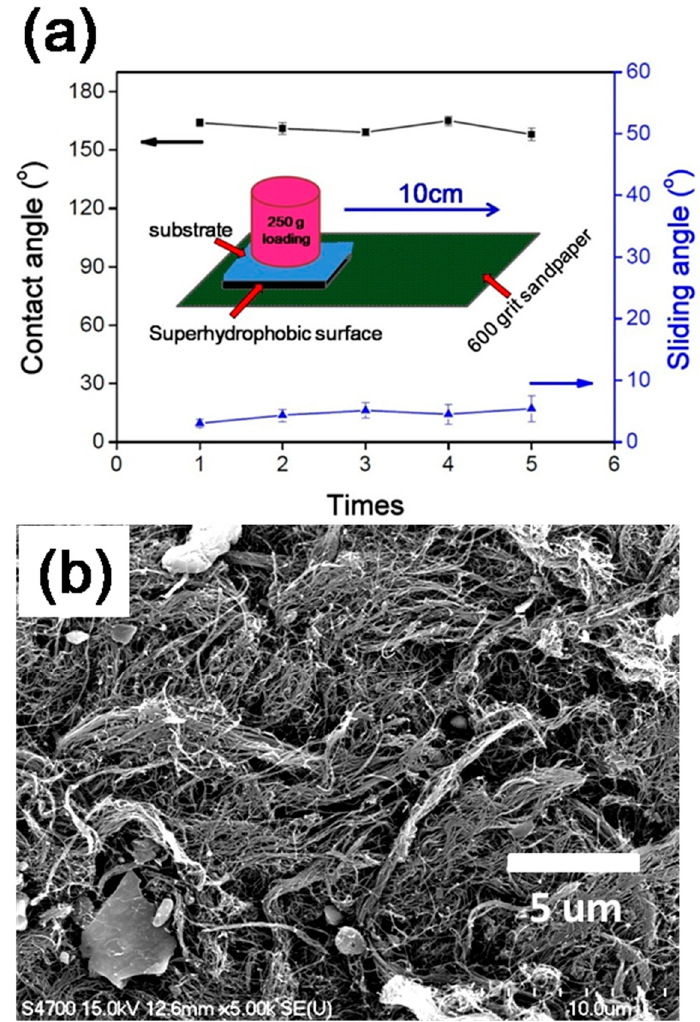
Figure 4. ( a ) Plot of the water contact/sliding angles as a function of the number of times of sandpaper abrasion. Inset: schematic of abrasion test. ( b ) SEM image of the superhydrophobic CNT/polybenzoxazine film after performing sandpaper abrasion after 5 times.